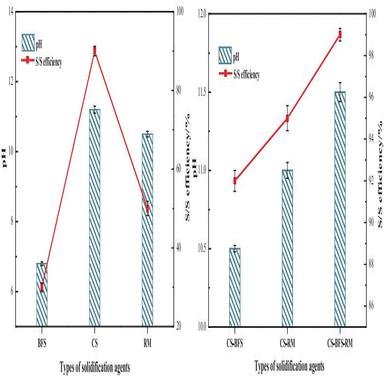
Solidification efficiency and pH of different S/S agents (a on the left and b on the right).